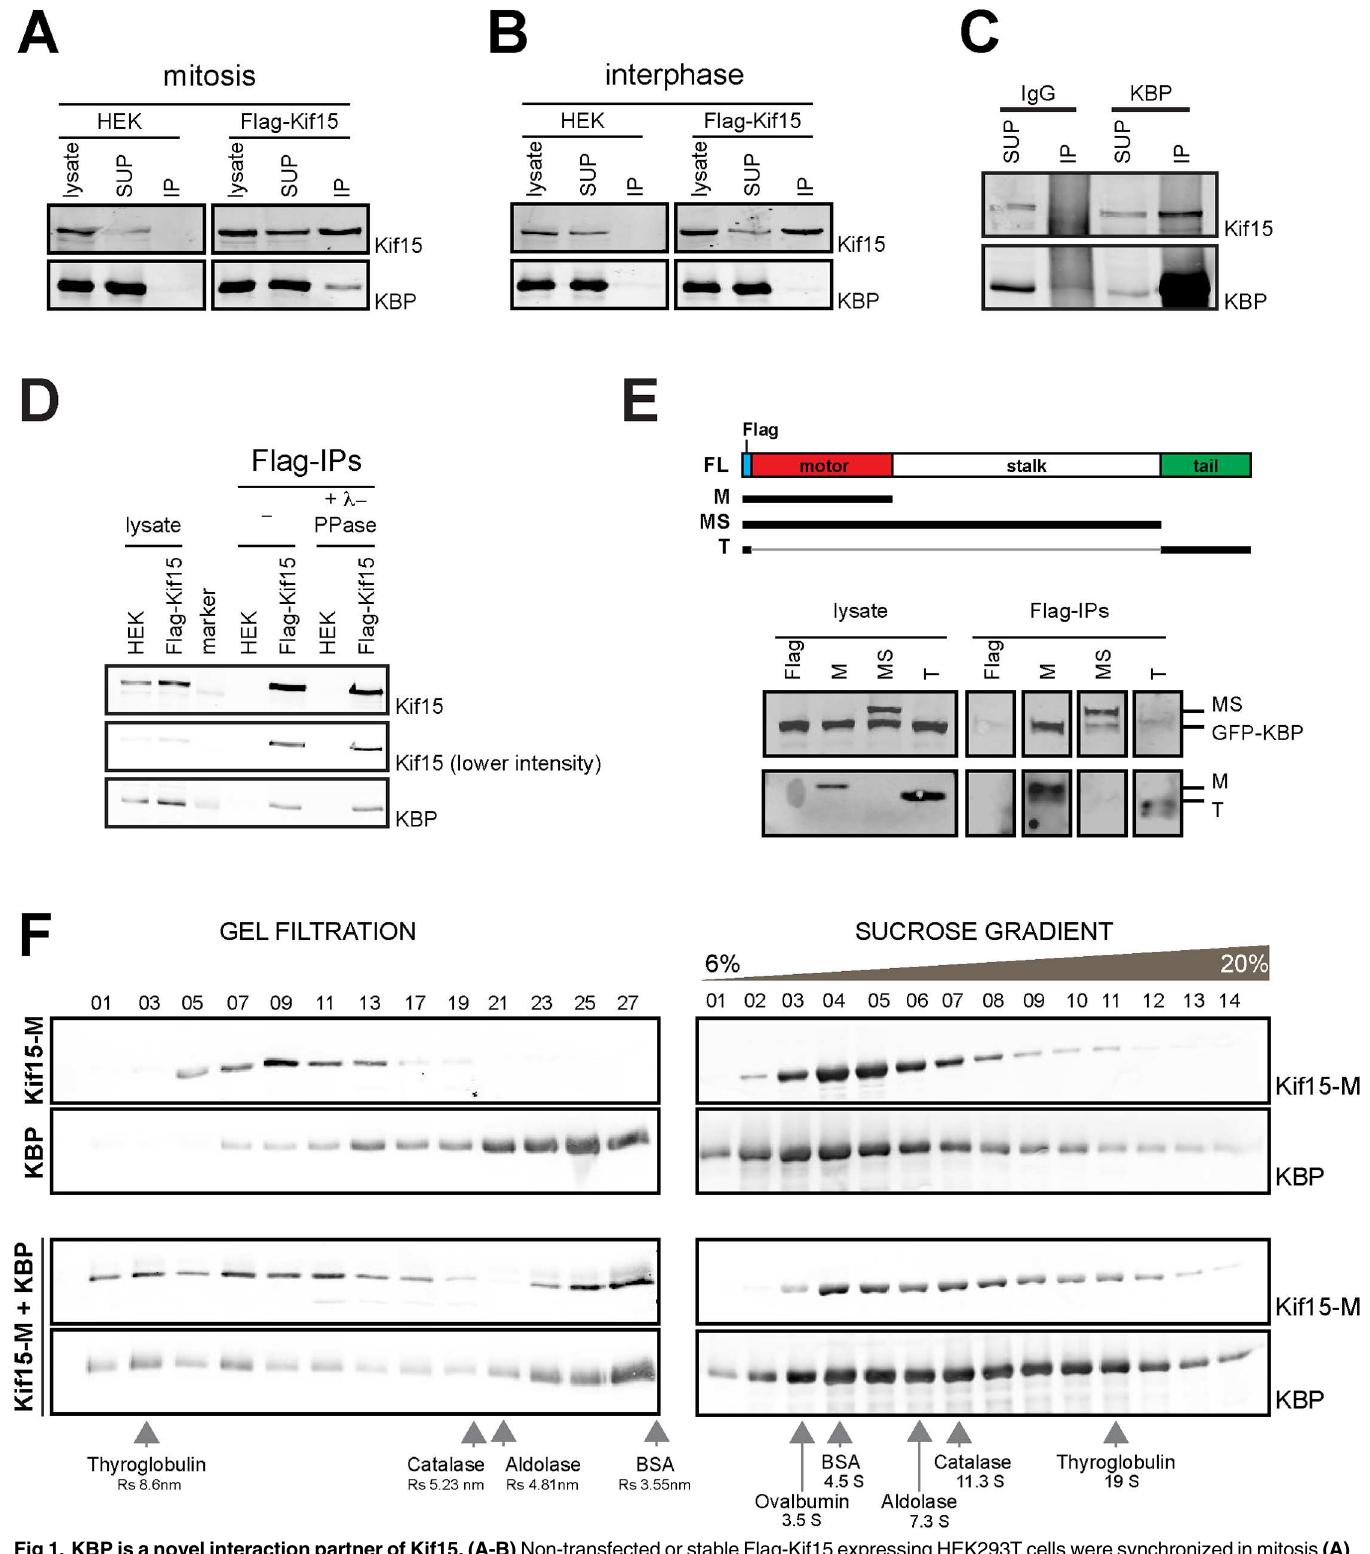
Fig 1. KBP is a novel interaction partner of Kif15. (A-B) Non-transfected or stable Flag-Kif15expressingHEK293T cells were synchronizedin mitosis (A) or interphase (B) and the correspondingcell lysates were used for anti-Flag immunoprecipitation.Cell lysates and immunoprecipitatedproteins were resolved